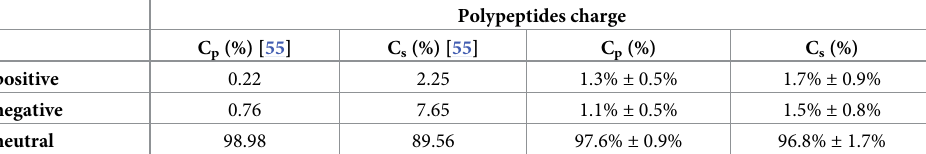
Table 3. Comparison of fibroin-derived polypeptides charge (right–from literature,